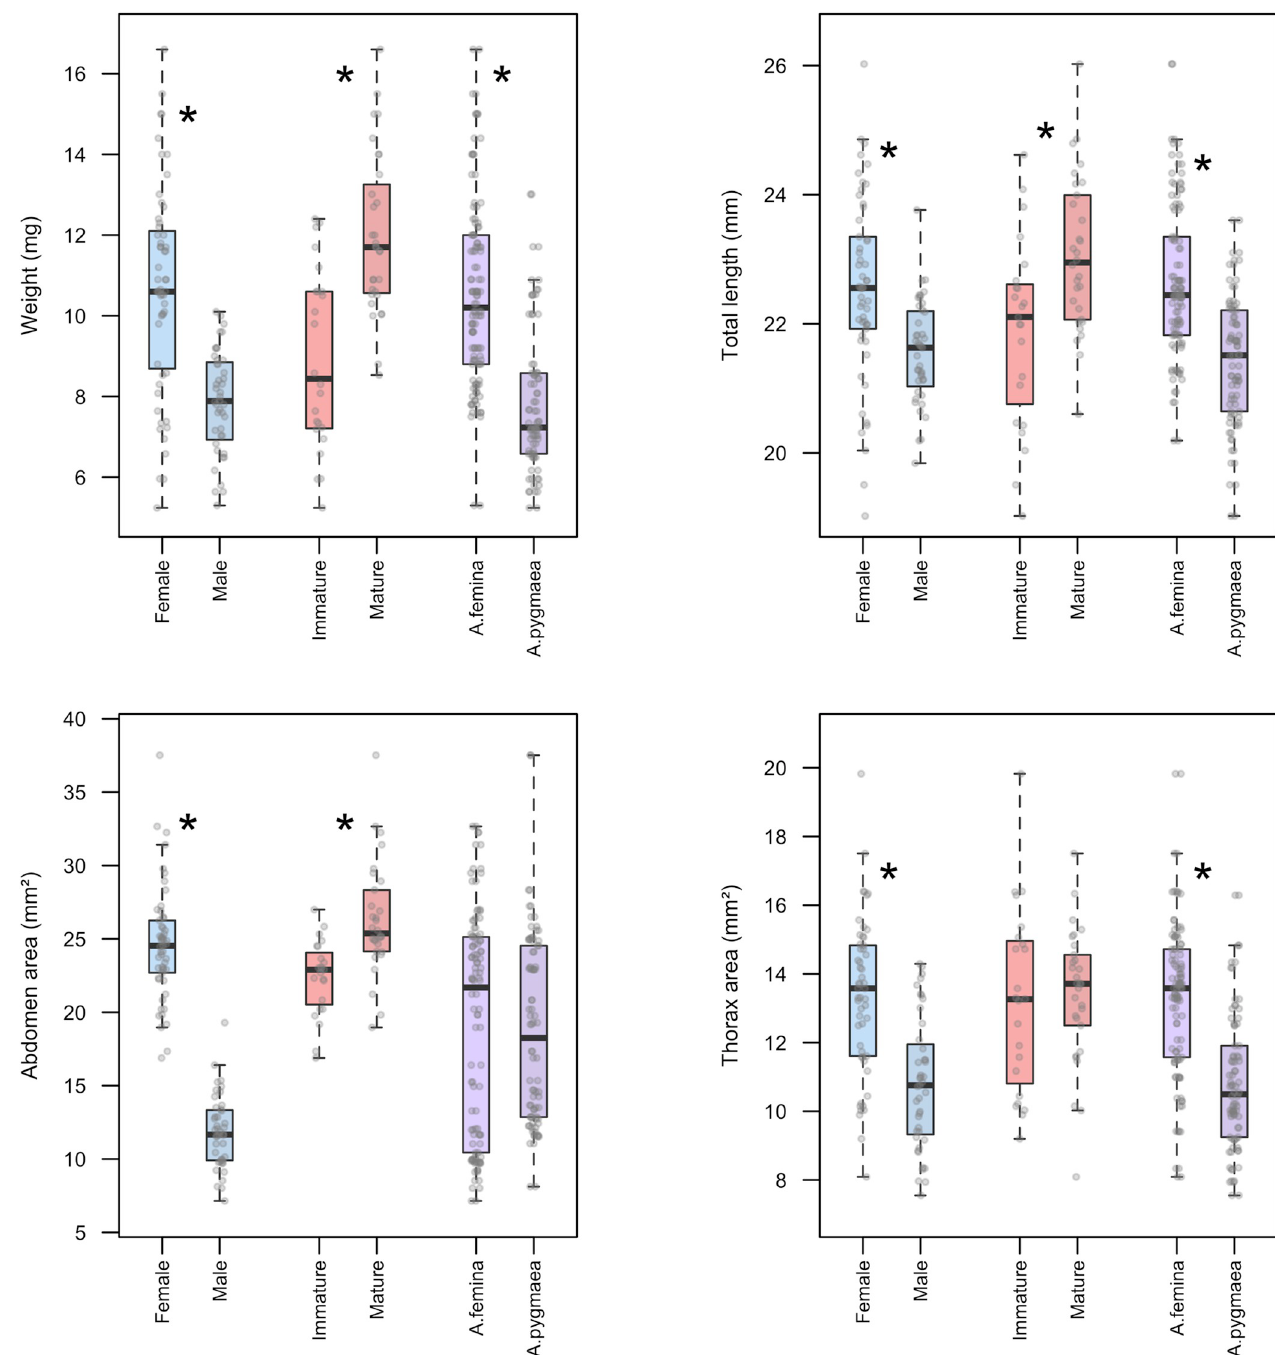
Fig 2. Morphometric measurements of non-parasitized females, males, immature and mature females of Agriocnemis femina and Agriocnemis pygmaea respectively. (a) Body weight of females and males; immature and mature females; Agriocnemis femina and Agriocnemis pygmaea . (b) Total length of females and males; immature and mature females; femina and A . pygmaea . (c) Abdomen area of females and males; immature and mature females; A . femina and A . pygmaea . (d) Thorax area of females and males; immature and mature females; A . femina and A . pygmaea . The boxplots indicate the median, 25th and 75th percentiles. The error bars extend downward from the first quartile to the minimum and upward from the third quartile to the maximum data points. Data points which are 1.5 times greater than the interquartile range are excluded. � symbolizes significant variation between studied groups.